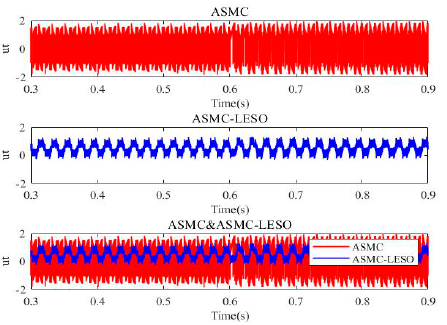
Figure 11. Tracking and error comparison curves of the ASMC-LESO and ASMC.